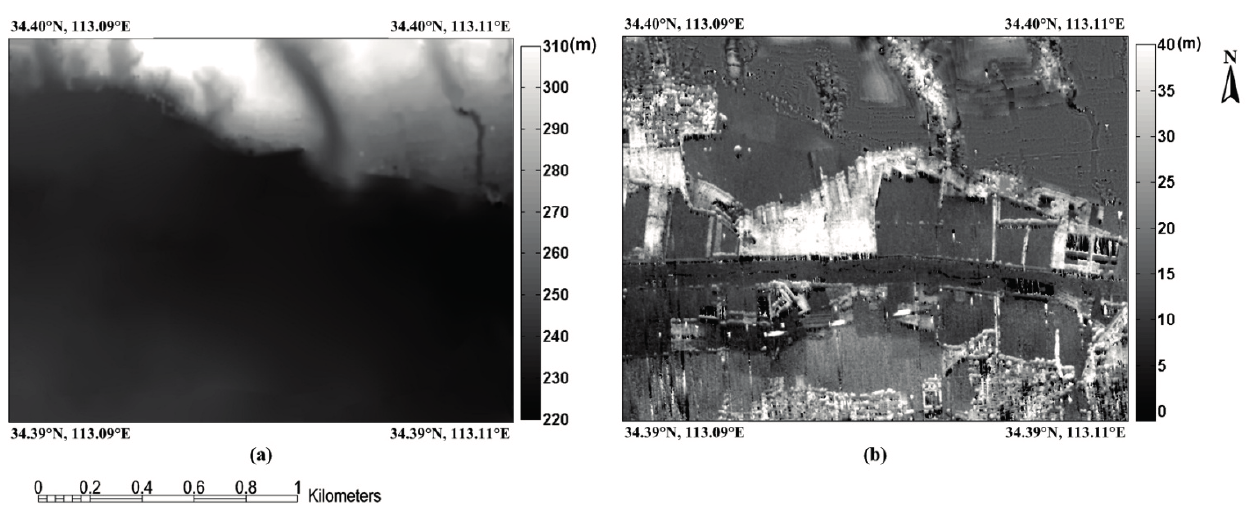
Figure 6. The DEM and nDSM of the study area. ( a ) DEM. ( b ) nDSM.